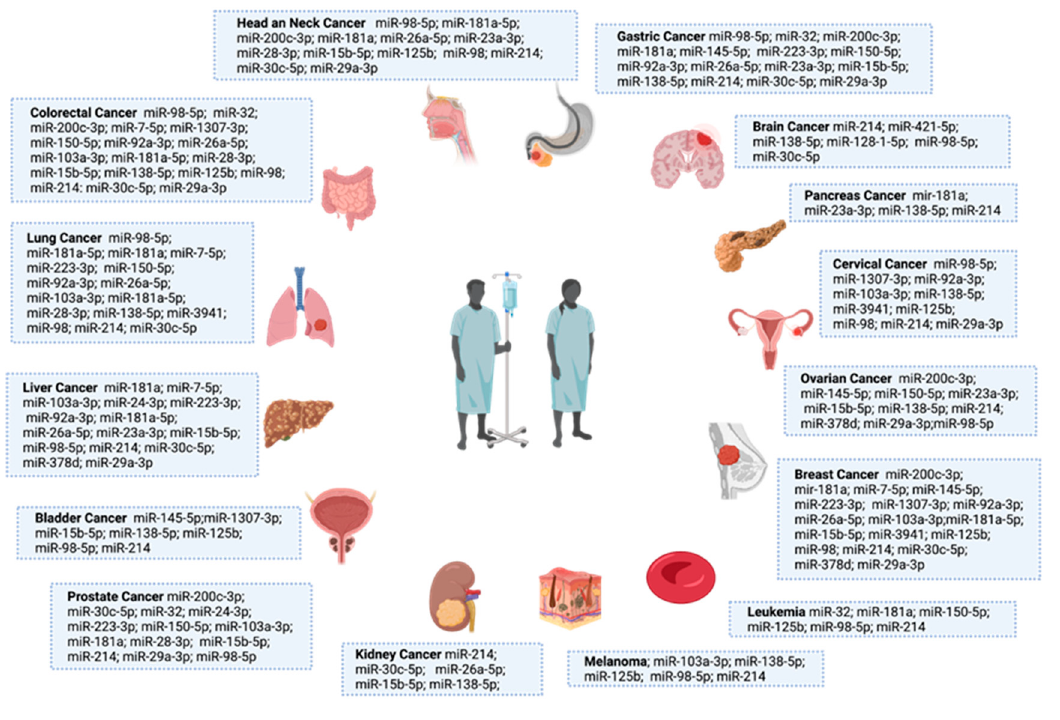
Figure 2. SARS-CoV-2 related miRNAs deregulated among 15 cancer types (gastric, brain, pancreas, ovarian, breast, leukemia, melanoma, kidney, prostate, bladder, liver, lung, colorectal and head and neck). This figure was created at BioRender.com (accessed on 6 May 2022).